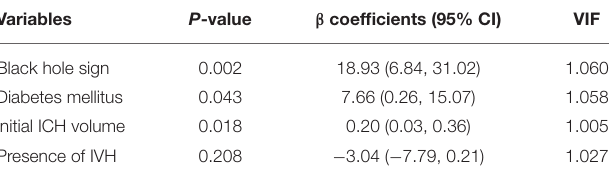
TABLE 3 | Multivariable linear regression analyses of iPHE volume after